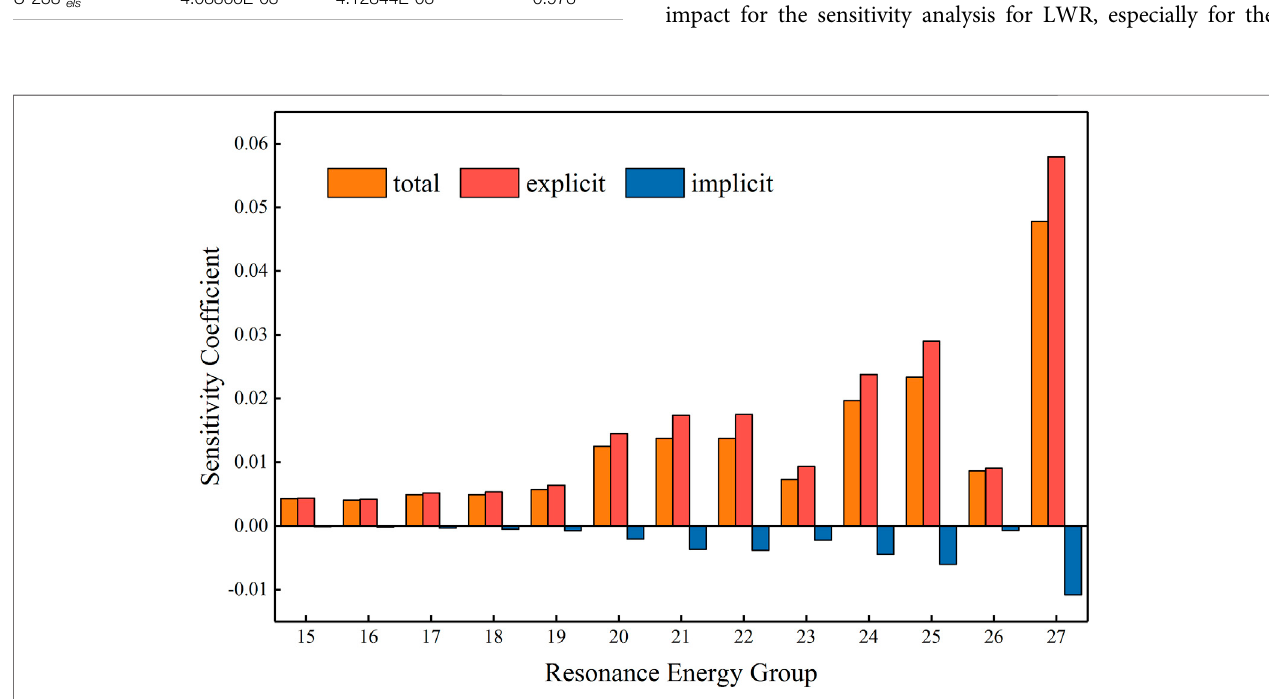
FIGURE 7 | Comparisons of implicit/explicit sensitivity coef fi cients.